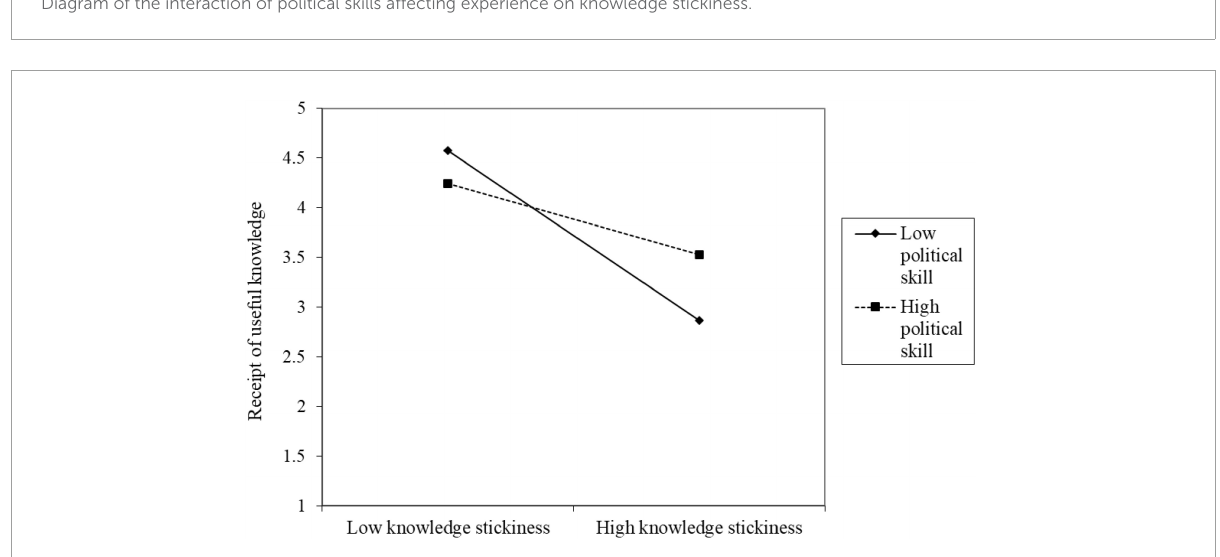
FIGURE3 Diagram of the interaction of political skills affecting knowledge stickiness on receipt of useful